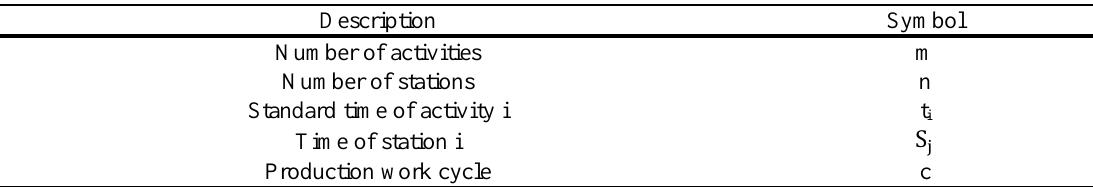
Table 2. Parameters and symbols used in the proposed